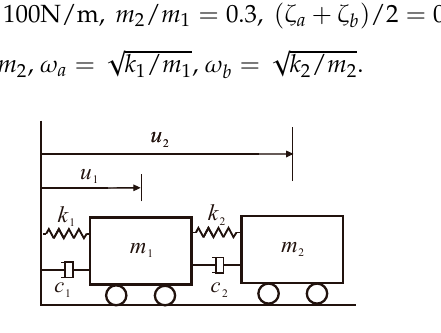
Table 1. The natural frequencies (rad / s) of the 2 DOFs system.